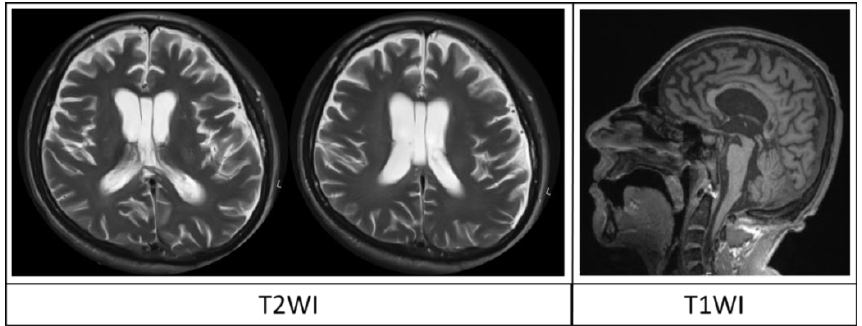
Figure 2. T2-WI and T1-WI of patient G., male, aged 26, in MCS due to traumatic brain injury 6 months prior to MRI (see patient No 10 in Table 2 for detailed information). Conventional MRI revealed ventricular enlargement with Evans index of 0.34 (DOC-MRIDS score 1), sulcal widening up to 0.3 cm (score 1) and corpus callosum lesions (score 1), without diffuse cortical atrophy, leukoaraiosis, corpus callosum and brainstem degeneration (score 0). The total DOC-MRIDS score was 3, corresponding to MCS, and was in agreement with clinical examination (CRS-R-11).